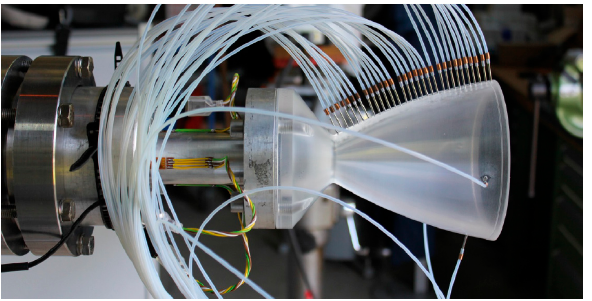
Figure 25. Experimental nozzle used in the experimental work. Reprinted with permission from Ref. [43] (2017).